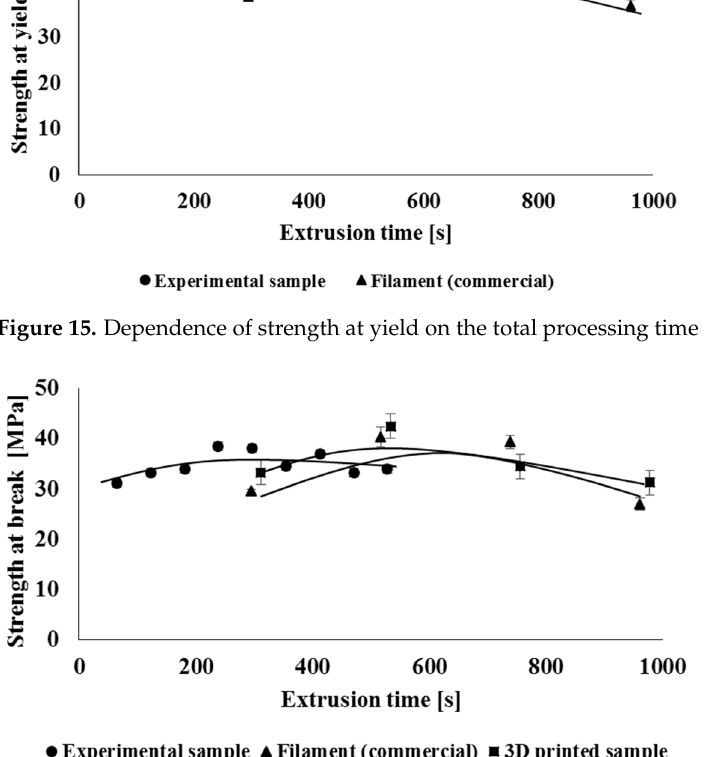
Figure 16. Dependence of tensile strength at break on the total processing time of the polymeric material.